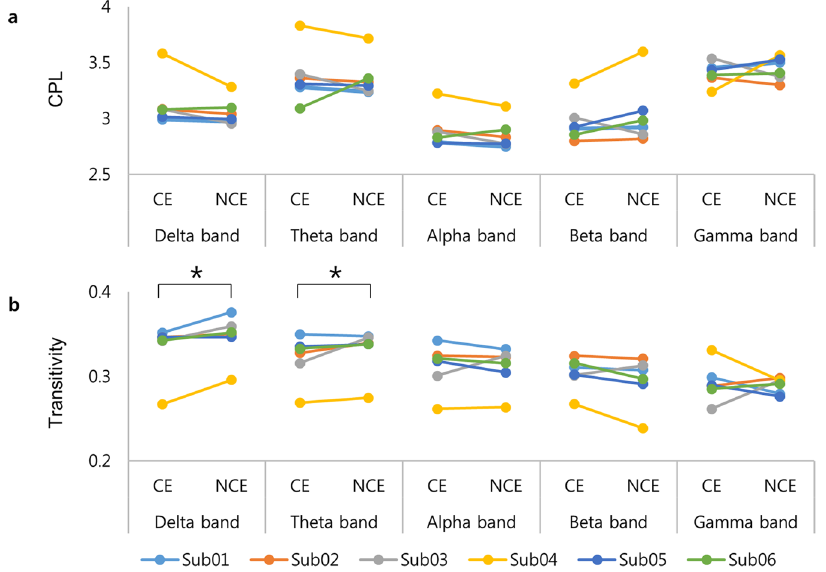
Figure 2. Global network properties of CE and NCE based on PLV. ( a ) Characteristic path length (CPL) and ( b ) transitivity in all frequency bands for all subjects. The error bars show the standard error. The asterisks indicate significant differences in the mean transitivity between CE and NCE using multi-threshold permutation correction. PLV = phase-locking value; CE = conscious experience; NCE = no conscious